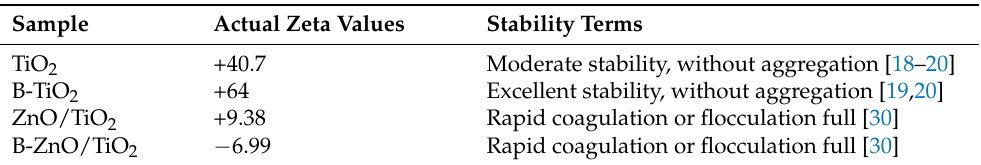
Table 3. Zeta potential value for pure TiO 2 , B-TiO 2 , ZnO/TiO 2, and B-ZnO/TiO 2 measured at room temperature.